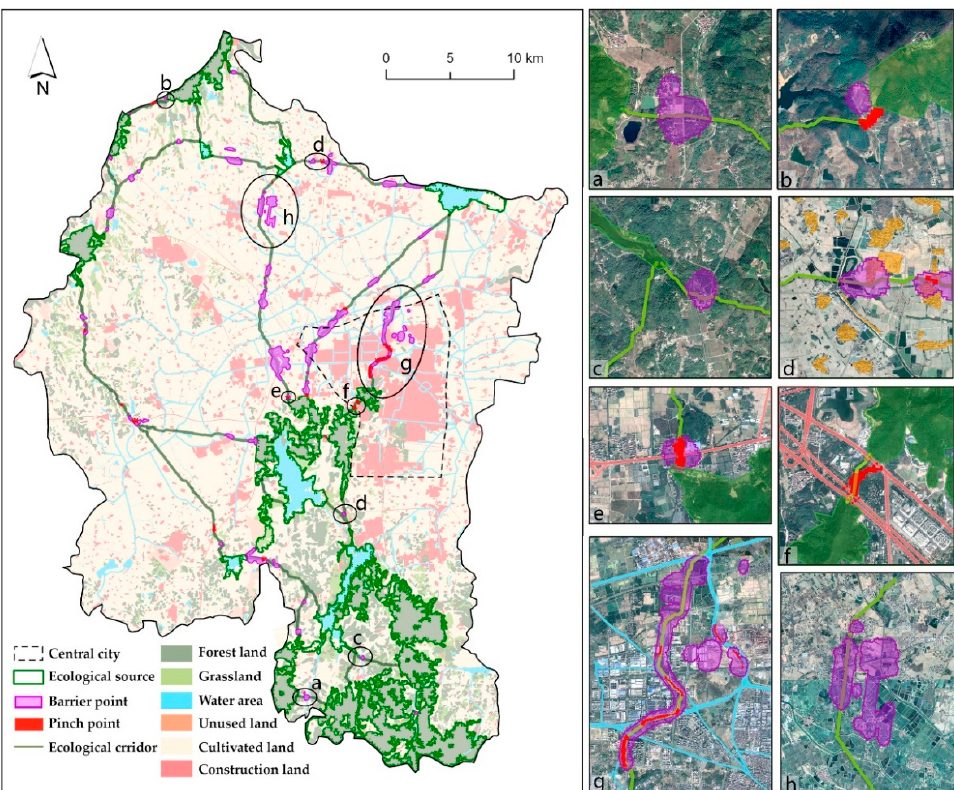
Figure 14. Typical ecological-restoration areas. ( a , b ): typical for farmland remediation; ( c , d ): typical for rural-settlement remediation; ( e , f ): typical for traffic optimization; ( g , h ): typical for comprehensive improvement.